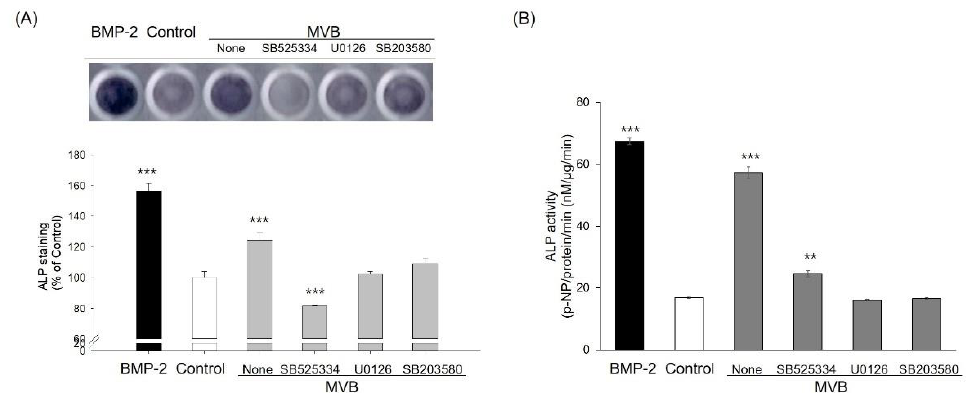
Figure 3. E ff ect of TGF- β signaling inhibitors on osteoblast di ff erentiation. ALP staining ( A ) and ALP Figure 3. Effect of TGF-β signaling inhibitors on osteoblast differentiation. ALP staining ( A ) and ALP 390 activity ( B ) of C3H10T1 / 2 cells by MVB and TGF- β signaling inhibitors. Significant di ff erences were activity ( B ) of C3H10T1/2 cells by MVB and TGF-β signaling inhibitors. Significant differences were 391 observed when compared with the controls: ** p < 0.01, *** p < observed when compared with the controls: ** p < 0.01, *** p < 0.001. 392